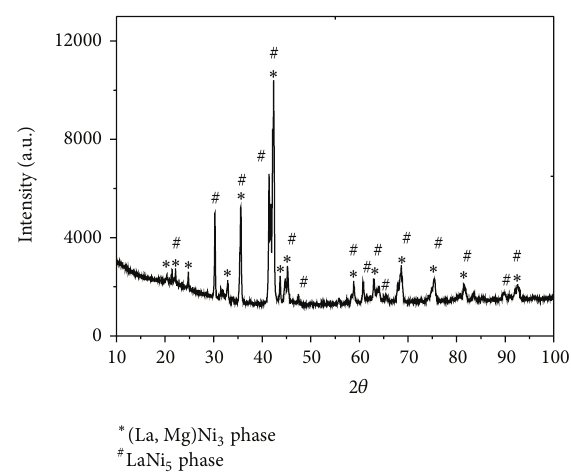
Figure 1: X-ray diffraction patterns of La 0.96 Ce 0.04 Mg 0.15 Al 0.05 Ni 2.8